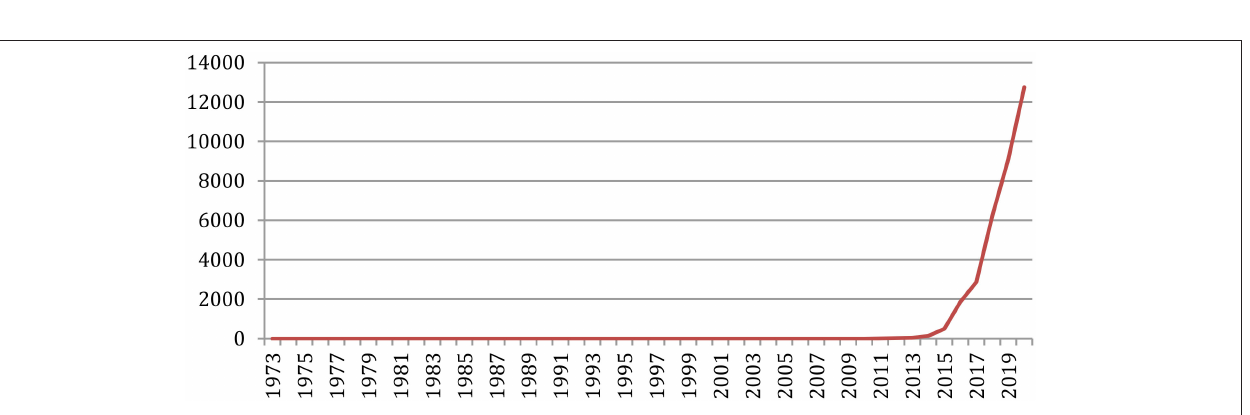
FIGURE 29 | Number of references to arXiv